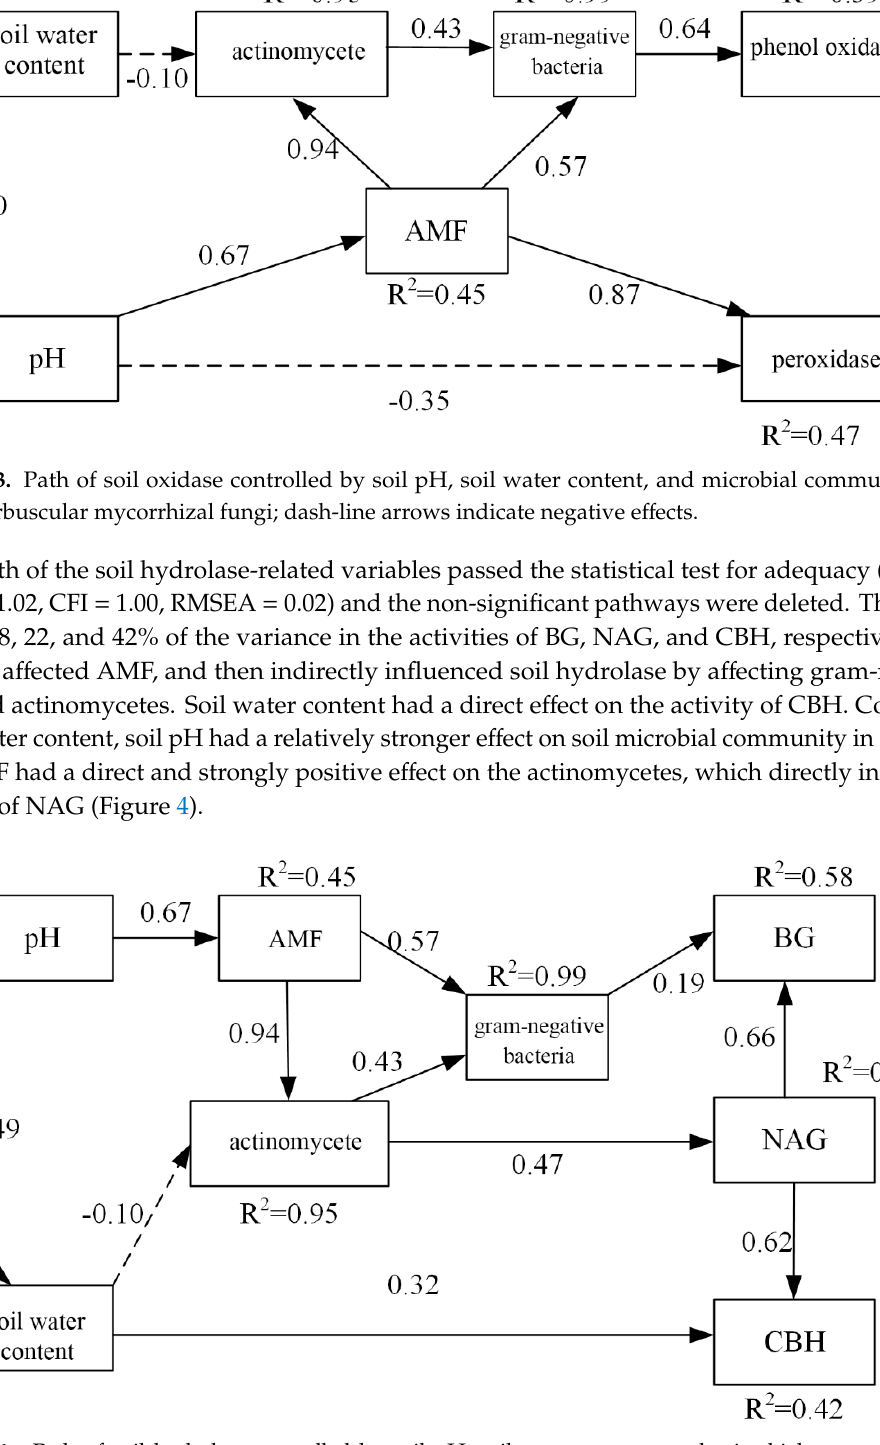
Figure 4. Path of soil hydrolase controlled by soil pH, soil water content, and microbial community. AMF: arbuscular mycorrhizal fungi; BG: β -glucosidase; NAG: N -acetyl- β -glucosidase; CBH: cellobiohydrolase. Dash-line arrows indicate negative effects.